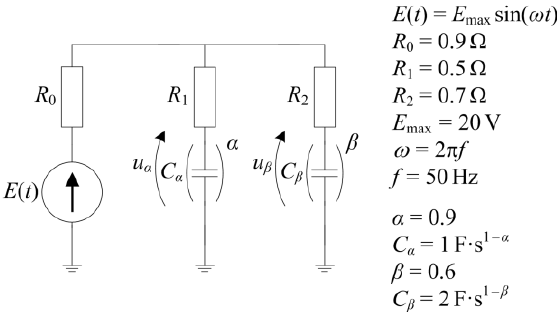
Fig. 1. Exemplary circuit example with a sinusoidal source and fractional elements .